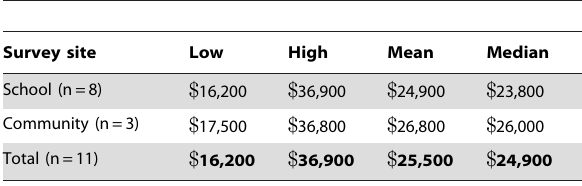
Table 11. Total TAS operational research costs for school and community-based